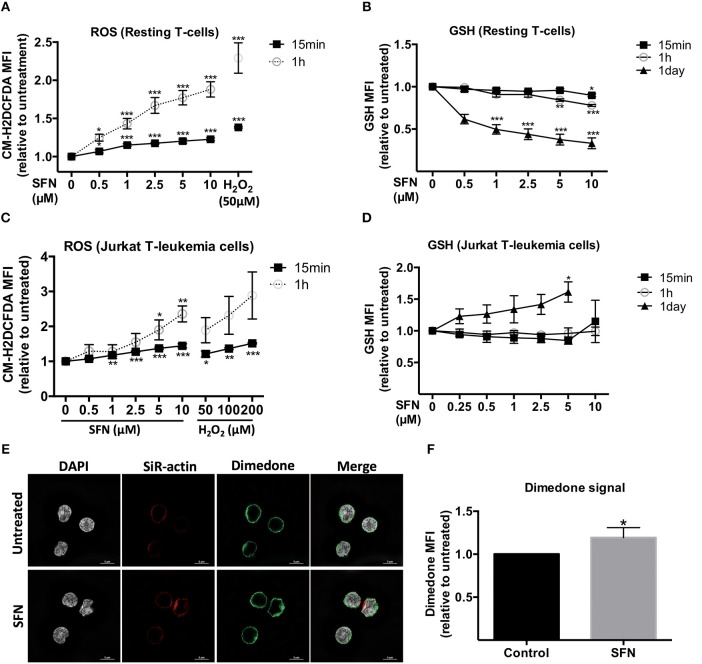
Influence of SFN on the redox state of untransformed human T-cells and Jurkat T- leukemia cells. (A,C) Intracellular ROS levels in T-cells and Jurkat T- leukemia cells, respectively, were assessed by flow cytometry. Cells were pre-loaded with CM-H2DCFDA and, thereafter, treated without or with SFN as indicated for different time points (n = 3; mean; SE; *p < 0.05, **p < 0.01, ***p < 0.001). (B,D) Intracellular GSH levels of T-cells and Jurkat T-leukemia cells, respectively, were assessed by flow cytometry. Cells were treated with SFN as indicated for different time points and stained with ThiolTrackerTM violet dye for 15 min (n = 3; mean; SE; *p < 0.05, **p < 0.01, ***p < 0.001). (E) Sulfenylated cysteines in T-cells were detected by microscopy. SFN treated T-cells were fixed and permeabilized, stained with DAPI (white), a dimedone specific antibody (green), and SiR-actin (blue). The merged image represents the digital overlay of all four colors. Images are representative for three experiments. (F) Quantititive analysis of cysteine sulfenylation by flow cytometry. Histogram shows the MFI relative to control of three independent experiments (n = 3; mean; SE; *p < 0.05).